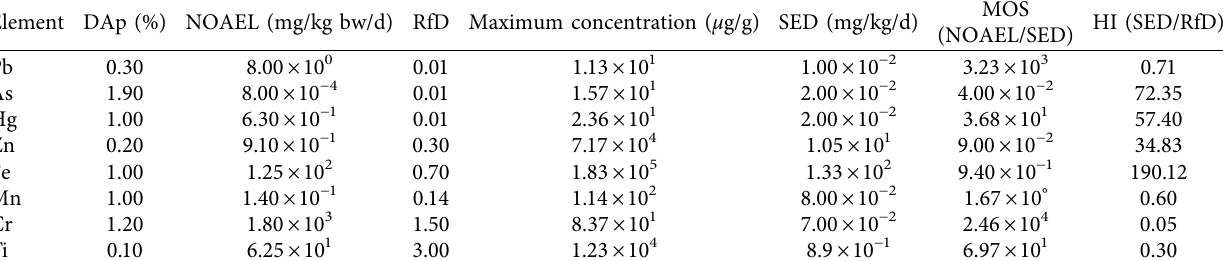
Table 3: Estimated noncancer risk assessment of trace elements in facial makeup.